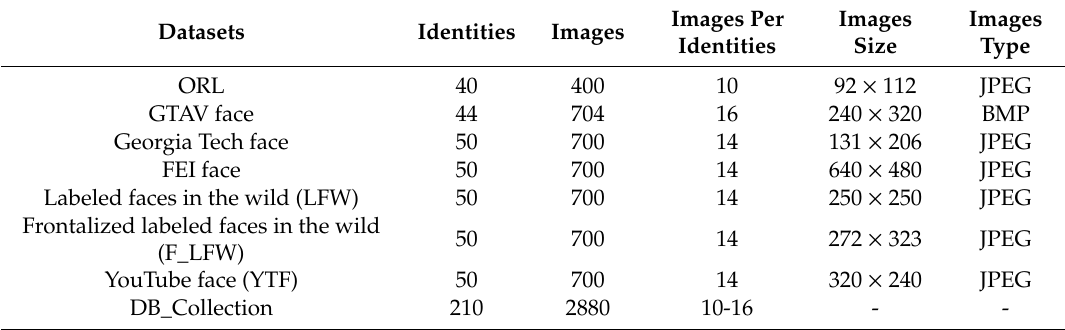
Table 4. Face datasets and their specifications used in our experiments.